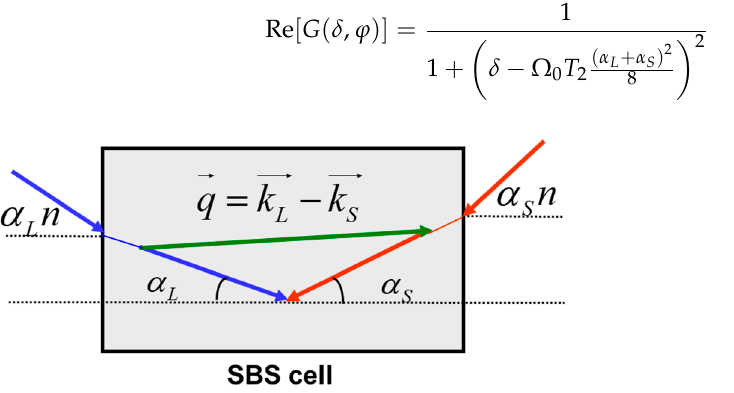
Figure 2. Brillouin interaction between plane waves in a volume medium. FWHM linewidth ∆ ν S ∼ 1/ π T 2 ( ∆ δ ∼ 1), determined by the sound relaxation time T 2 .